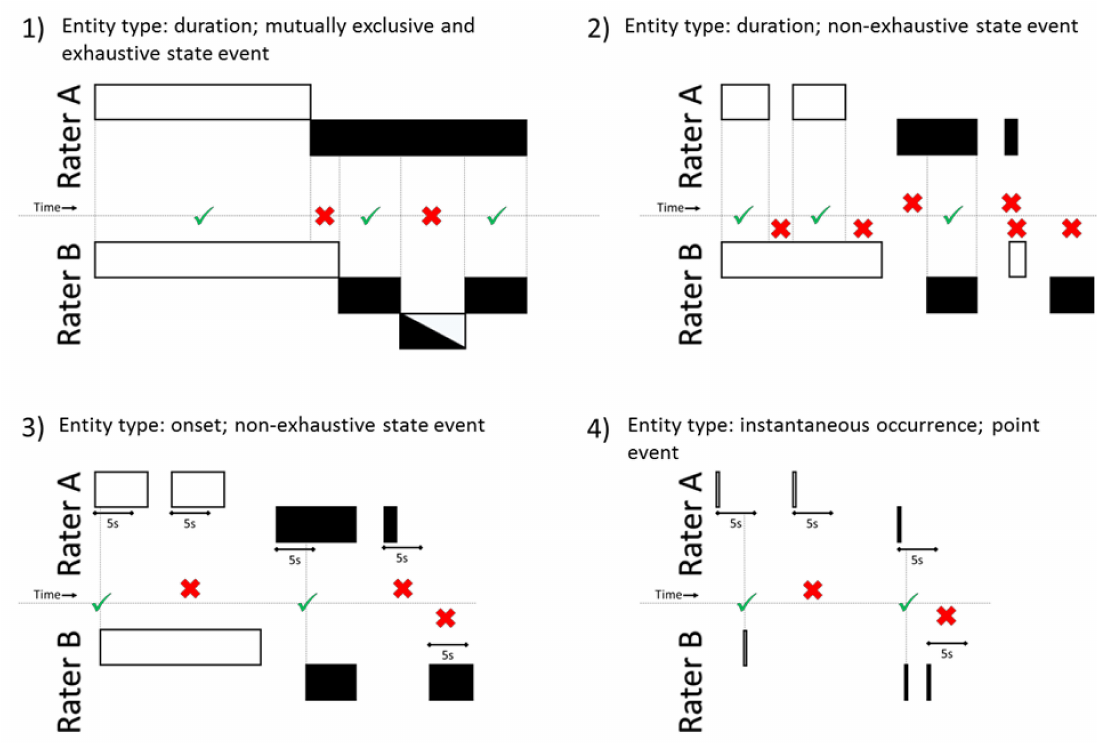
Figure 1. Examples of agreement determination between rater A and rater B for di ff erent entity types (instantaneous occurrence, onset of duration or duration). A check sign represents agreement, while a cross mark represents periods of non-agreement between the two raters. The color-coded boxes in part 1, 2 and 3 represent registered state events, while the lines in part 4 represent single point events. Recorded time goes from left to right. (1) Agreement on duration of mutually exclusive and exhaustive type of state event: Agreement was determined second-by-second for each event. (2) Agreement on duration of non-exhaustive type of state event: Agreement was determined second-by-second for each event. (3) Agreement on onset of duration of non-exhaustive type of state event: Agreement was determined if the two raters registered onset of the event within a 5-second tolerance window and calculated as [A yes , B yes ]. If only one rater had registered onset within the 5-second tolerance window, it was determined as the corresponding [A yes , B no ] or [A no , B yes ].(4) Agreement on instantaneous occurrence of point events: Agreement was determined if the two raters registered the point event within a 5-second tolerance window and calculated as [A yes , B yes ]. If only one rater had registered the point event within the 5-second tolerance window, it was determined as the corresponding [A yes , B no ] or [A no , B yes